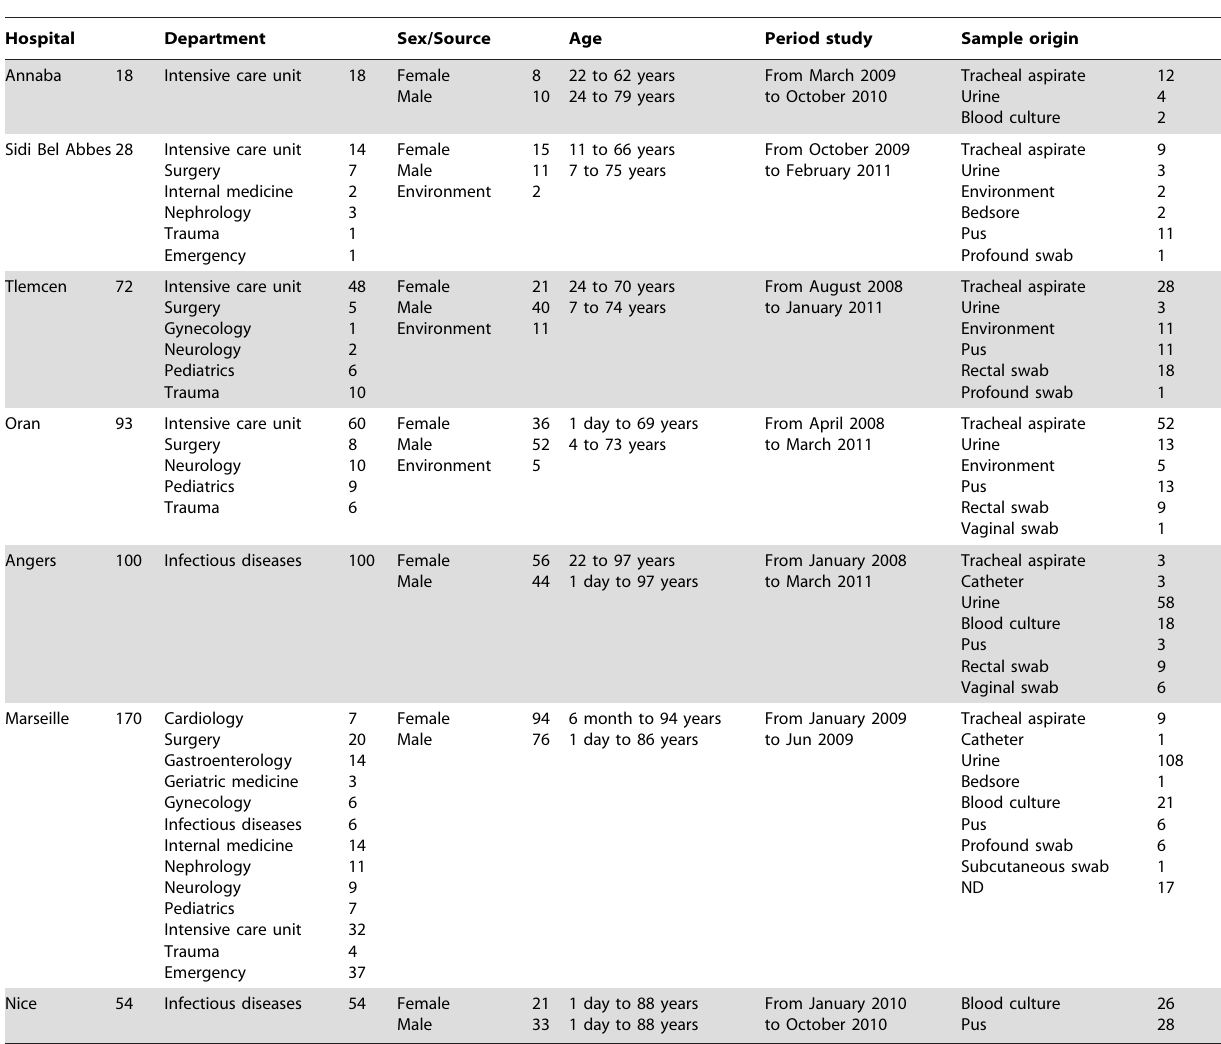
Table 1. Origin and repartition of strains used in this